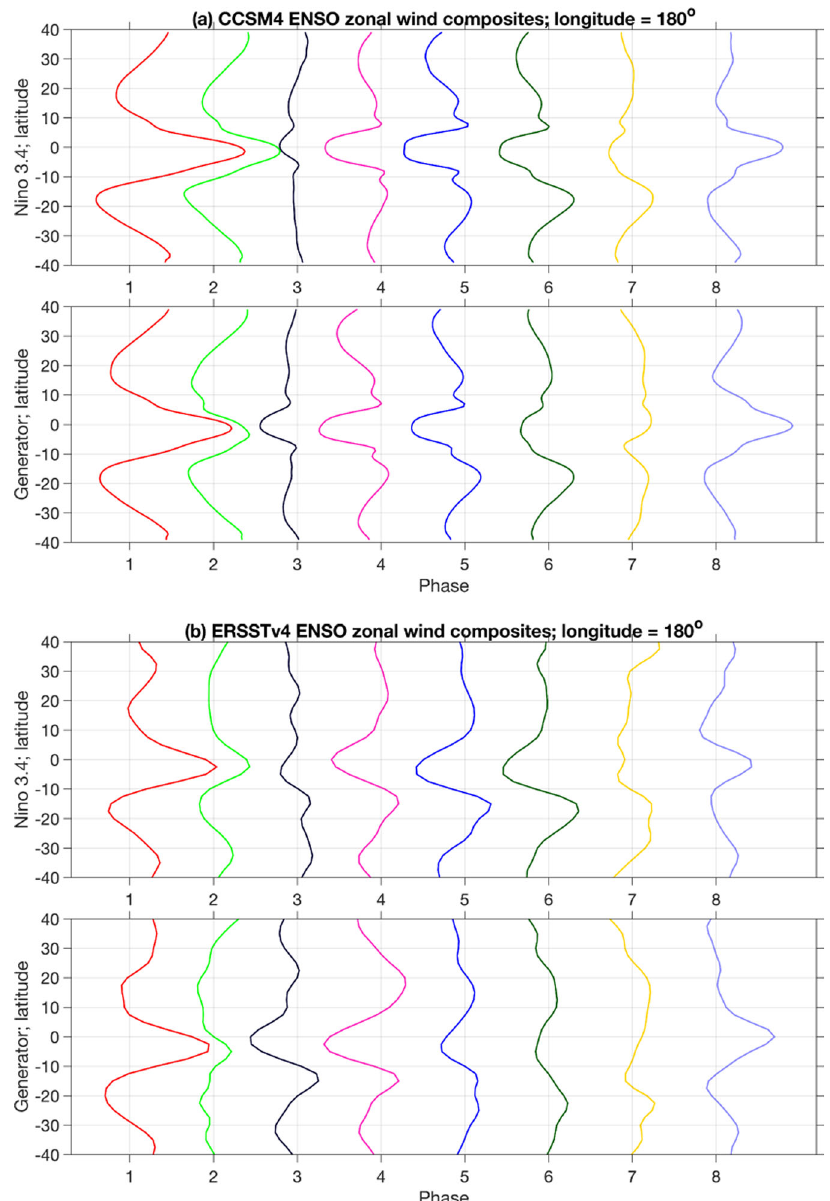
Fig. 8 Phase-composited surface zonal wind pro fi les for CCSM4 (a) and ERSSTv4 (b). Each set of panels shows composites of surface zonal winds sampled at the dateline along the meridional interval 40 ∘ S – 40 ∘ N, based on the Niño 3.4 (top panels) and generator (bottom panels) ENSO phases from Fig.